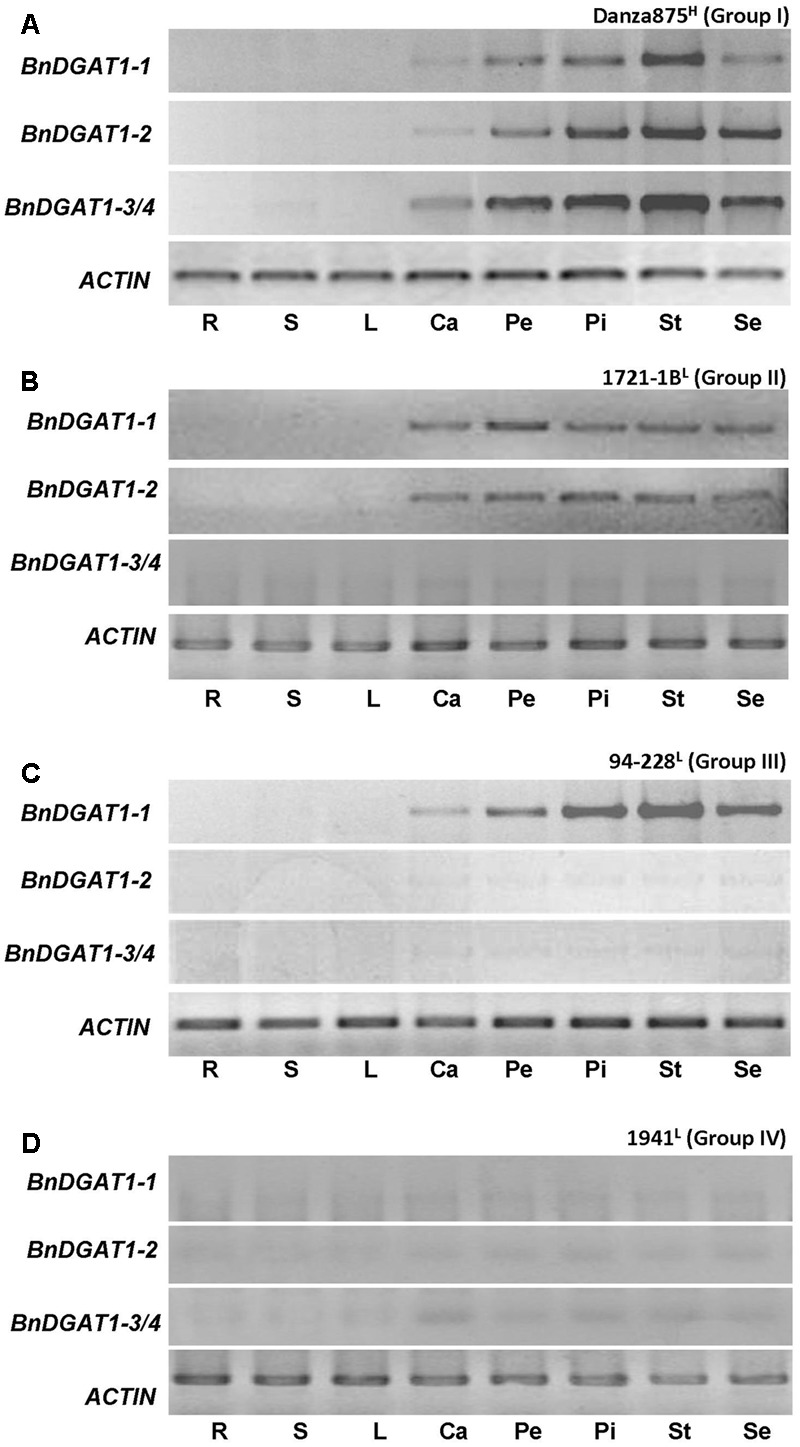
Tissue specific expression patterns of BnDGAT1s in B. napus. Roots (R), stems (S), leaves (L) and the third cauline leaves (Ca), of B. napus lines from four groups (A–D, represent group I–IV respectively) (one line was selected from each group) were collected on 28 DAP (days after pollination) and analyzed by RT-PCR. Petals (Pe), pistils (Pi), stamens (St), and sepals (Se) were collected at same stage and analyzed by RT-PCR. Actin was used as internal reference. Primers and semi-quantitative PCR conditions are described in Section “Materials and Methods.” L indicates low seed oil and H indicates high seed oil.